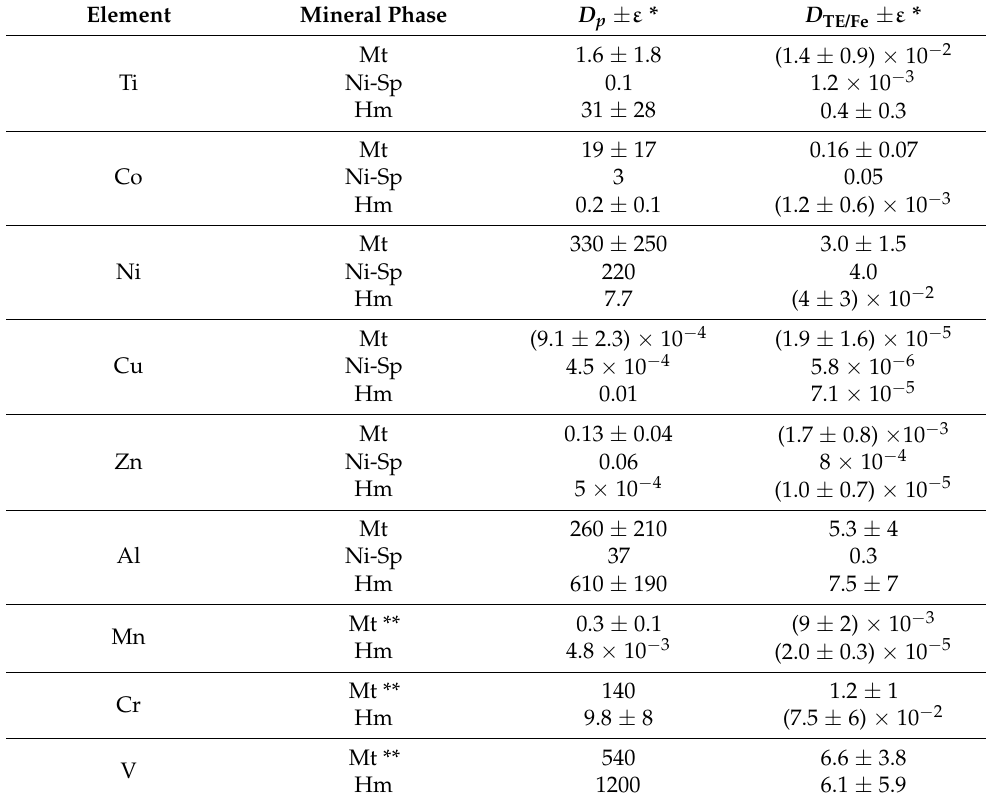
Table 2. Average partition and co-crystallisation coefficients of trace elements (TE) in magnetite (Mt), Ni-spinel (Ni-Sp) and hematite (Hm) in the system mineral–hydrothermal fluid at 450 ◦ C and 1 kbar.